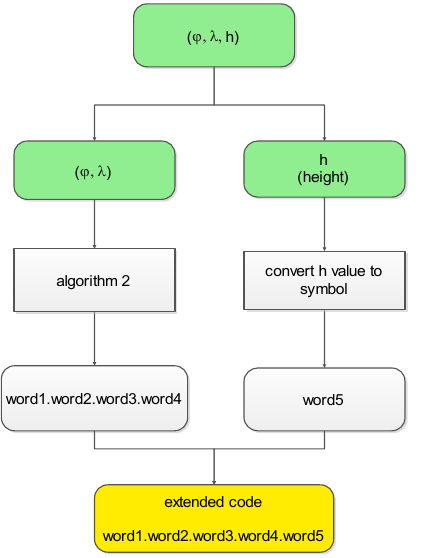
Figure 7. Work flow of extended reverse geocoding with five-